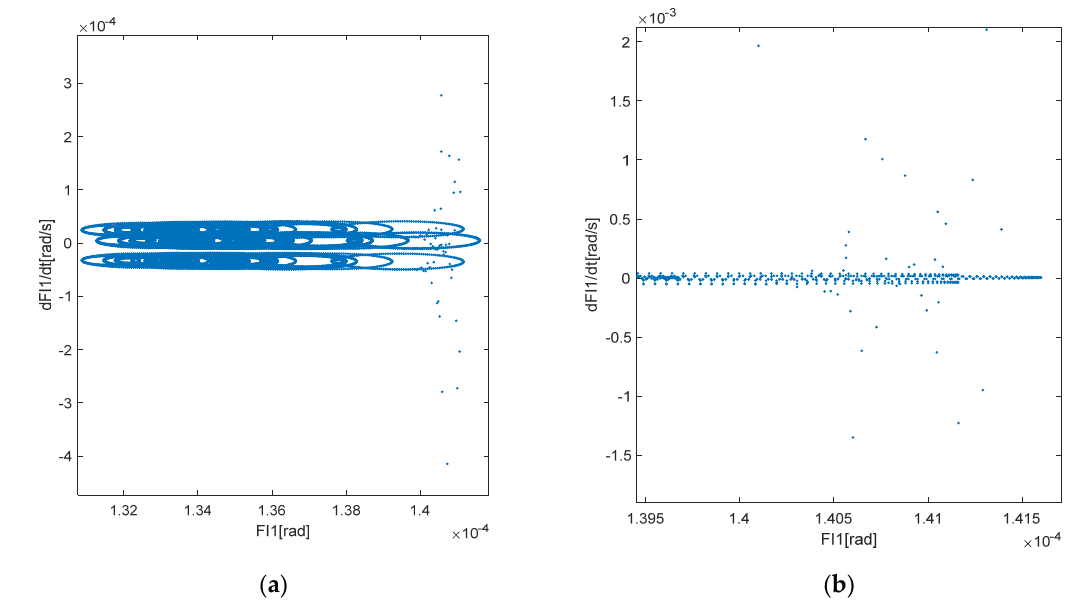
Figure 27. Poincaré Map of DIE1 for Figure 27. Poincar é Map of DIE1 for β ( b ) N =